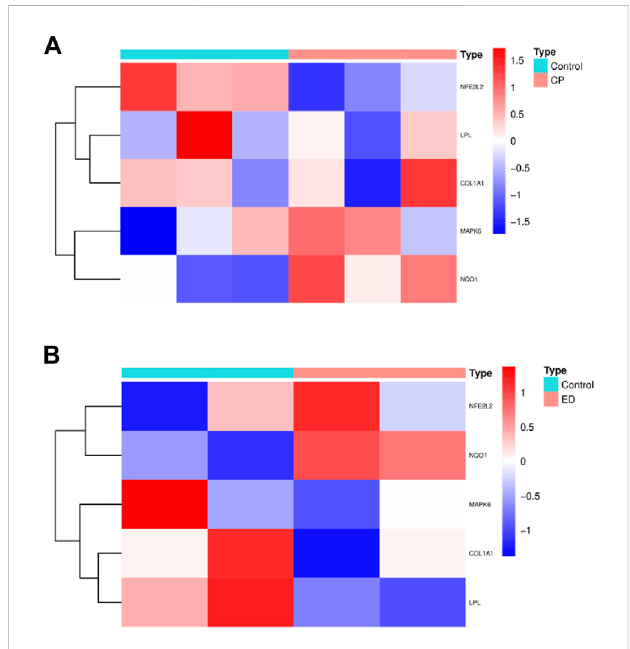
FIGURE 7 The pro fi ling of hub CPRGs in CP/CPPS (A) and ED-related cellular (B) gene sets. CP, chronic prostatitis; CPPS, chronic pelvic pain syndrome; CPRGs, CP/CPPS-related genes; ED, erectile